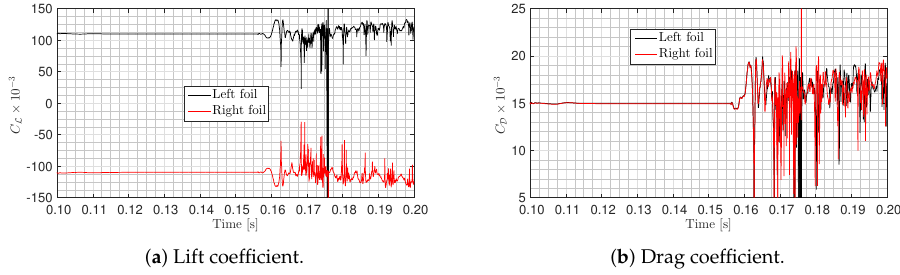
Figure 19. Illustration of an effect of DDES. Simulations were carried out using SST k − ω until t ≈ 0.155 s, after which the DDES approach was activated. Medium grid, U ∞ = 8 m/s, σ =